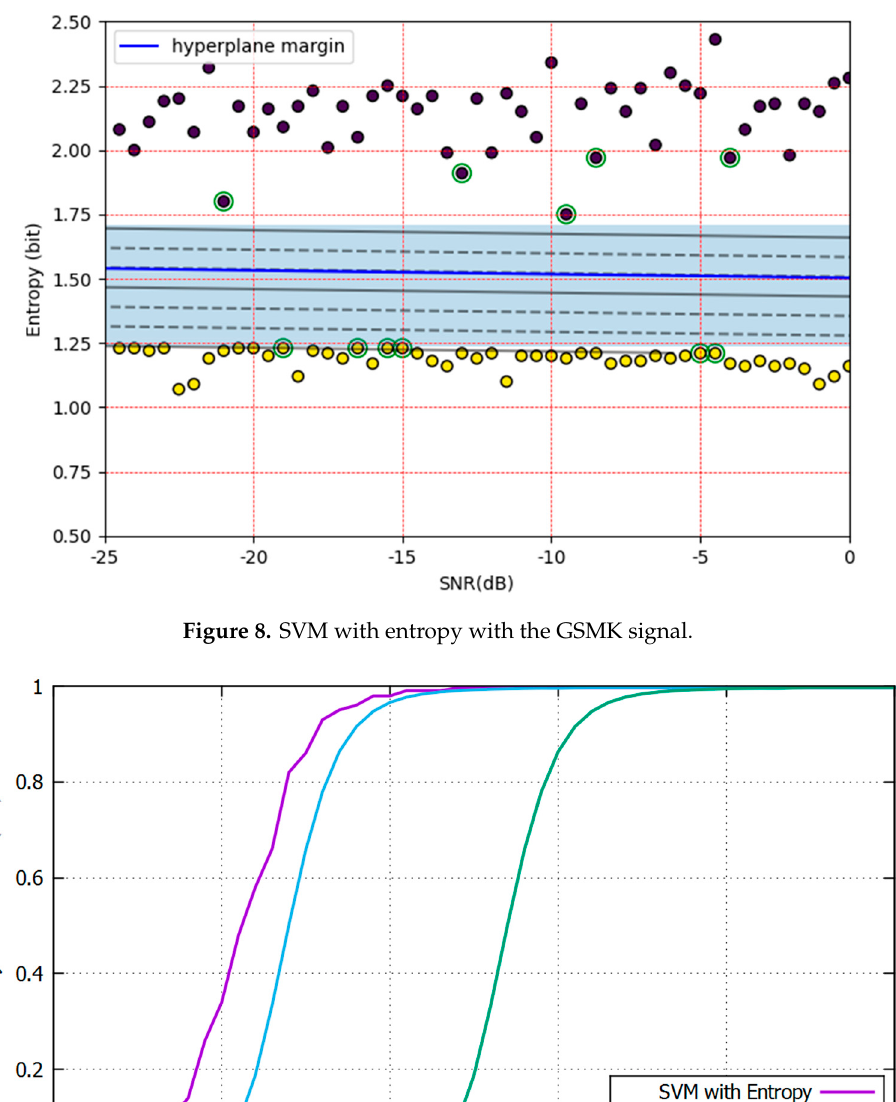
Figure 10. Entropy with and without of the orthogonal frequency division multiplexing (OFDM) signal. The SVM machine is implemented with these entropy values and the hyperplane and support vector are calculated by using the learning process, as can be seen in Figure 11. Notably, the margin is smaller than the GMSK signal. If a simple energy detector or entropy detector is used based on a threshold, the results will increase false alarm results, but with the SVM, the results are better for low SNR values and it is able to detect malicious PUE.